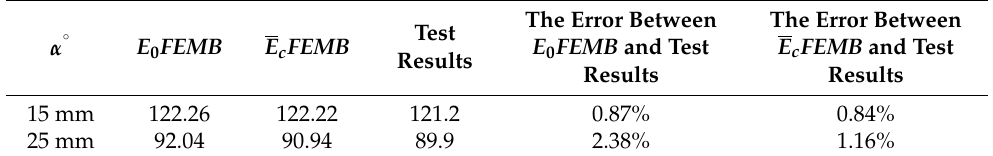
Table 5. Comparison of springback results in three-point bending.